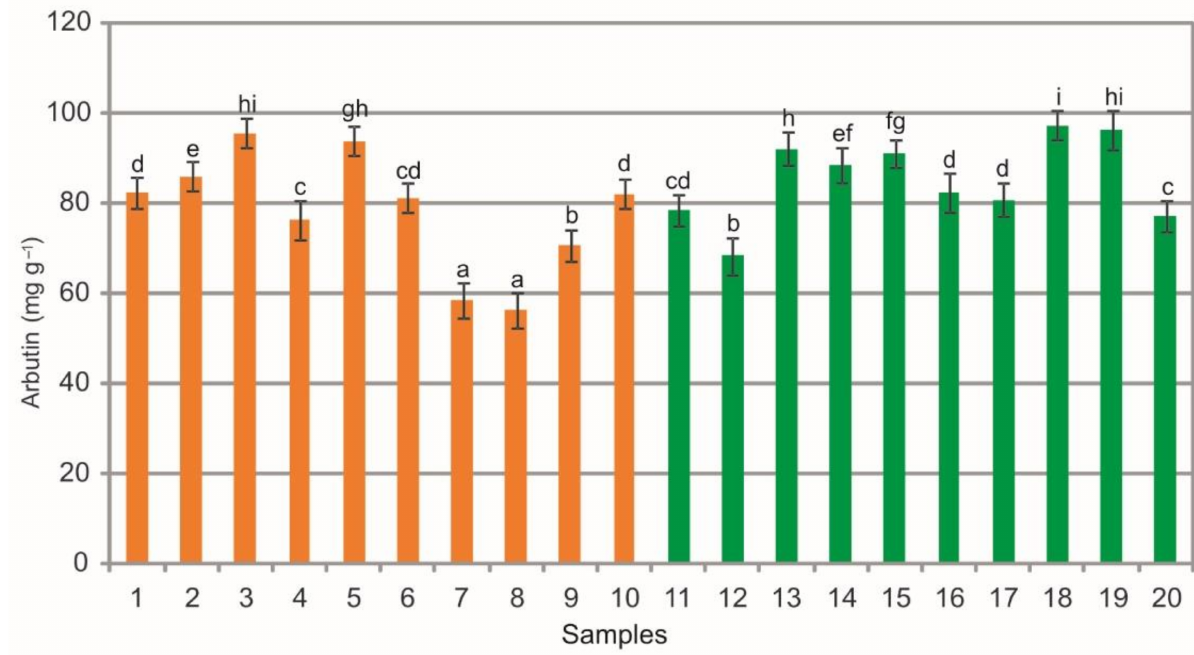
Figure 3. Arbutin contents (mg g − 1 ) in leaf extracts from bearberry plants collected in heathland populations (orange) and in pine forest populations (green). For each site, data are mean and SD. The values designated by the different letters are significantly different (Tukey test, p <